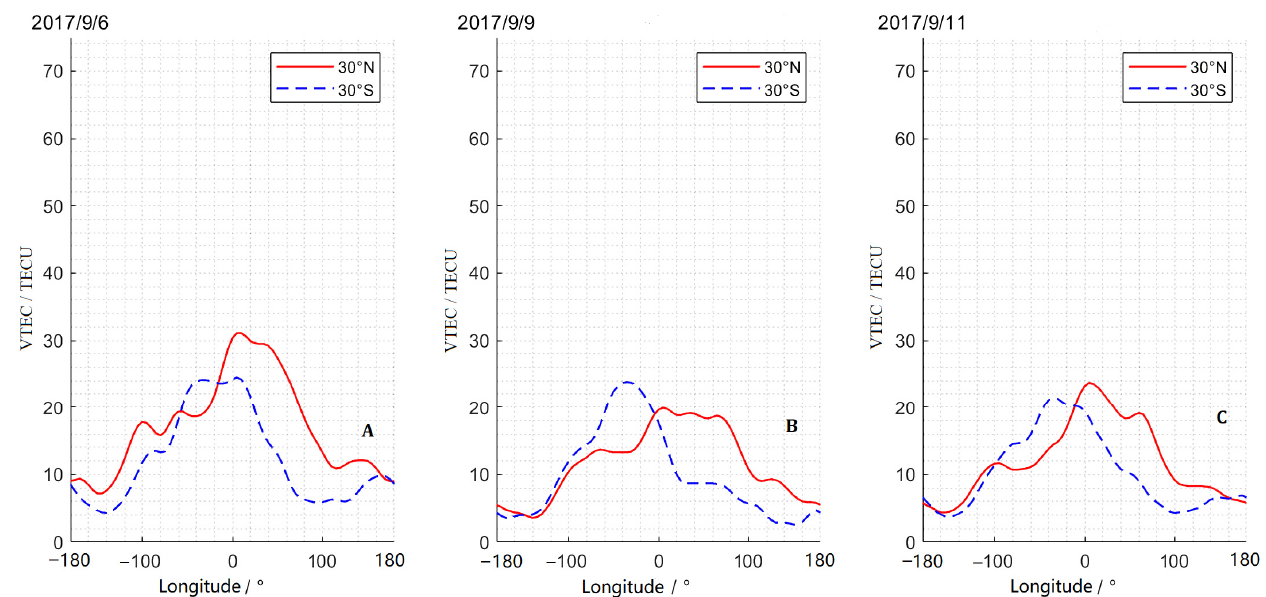
Figure 9. Fluctuation characteristics of VTEC on 20°N/S latitudes at UTC 14:00. Panels ( A – C ) represent the experimental results of the three stages before, during, and after the geomagnetic storm, respectively. The blue dotted line and the red solid line represent the southern and northern hemisphere VTEC, respectively, unit: TECU.